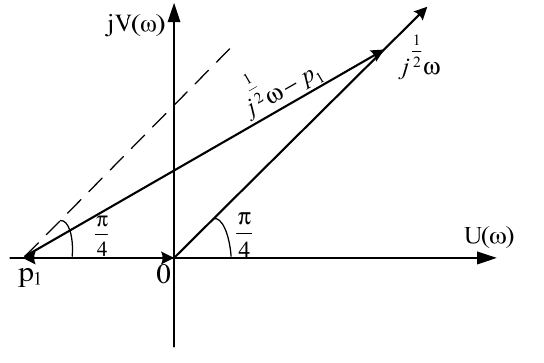
Figure 1. Displacement of the vector (cid:4672)𝑗